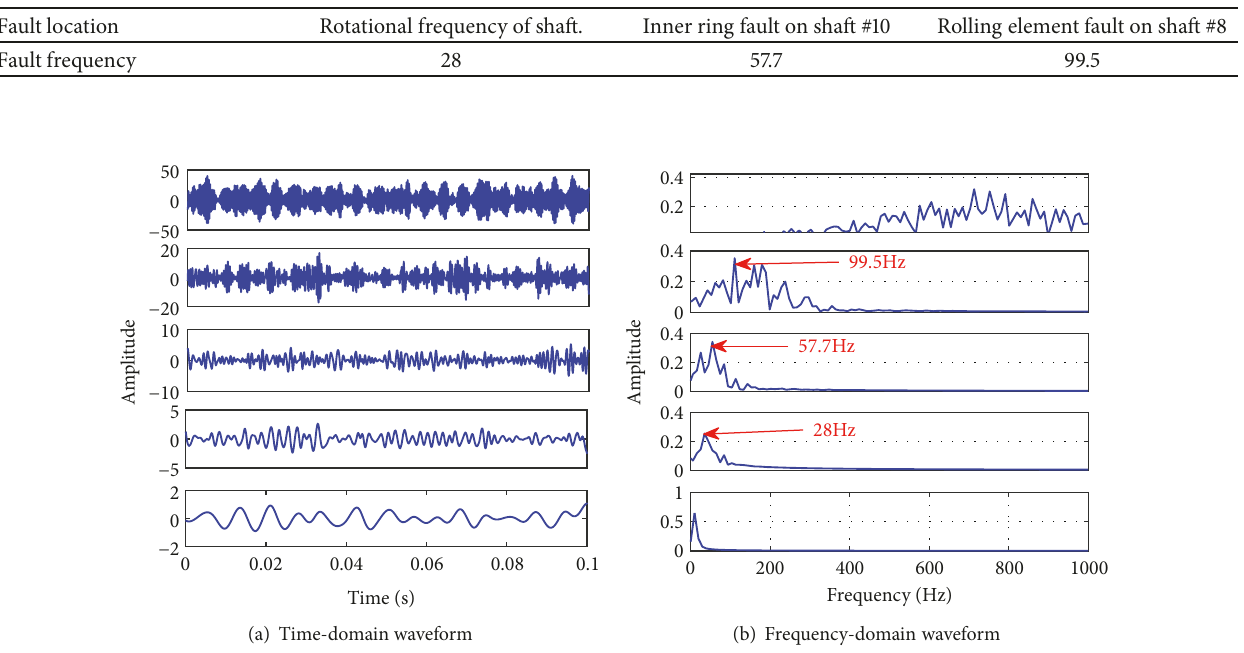
Figure 24: Improved ELMD decomposition